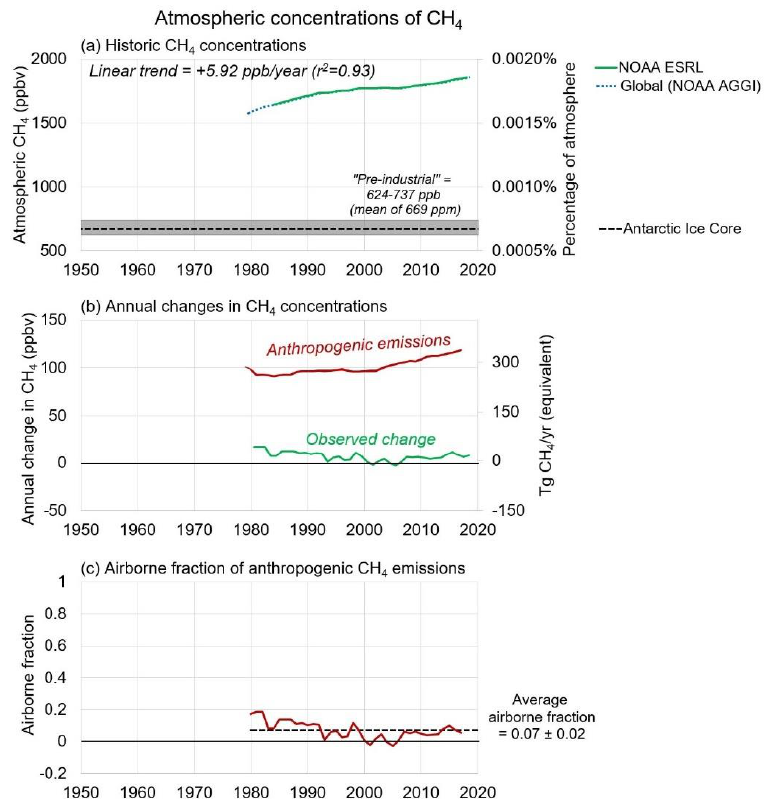
Figure 7. ( a ) Changes in annually averaged atmospheric CH 4 concentrations since direct and (almost) continuous measurements began in 1979. The estimates of pre-industrial concentrations derived from the Antarctic Law Dome ice core are shown with a grey band for comparison. ( b ) A comparison of the annual anthropogenic CH 4 emissions (red line) with the observed annual changes in atmospheric CH 4 (green line). ( c ) The “airborne fraction” for CH 4 , i.e., the fraction of anthropogenic CH 4 emissions that remained in the atmosphere for each year since 1980. Note that the airborne fraction was below 0 on three years (2001, 2004 and 2005). The horizontal axes correspond to years. If the Antarctic ice core estimates of past atmospheric CH 4 are inaccurate, then on the basis of the very low airborne fraction of 0.07 ± 0.02 over the instrumental record, it is quite plausible that most of the apparent trends in atmospheric CH 4 are due to variability in the natural sinks and sources. In that case, it would suggest that anthropogenic CH 4 emissions might not be influencing atmospheric concentrations, in which case they probably could be removed as a potential source of